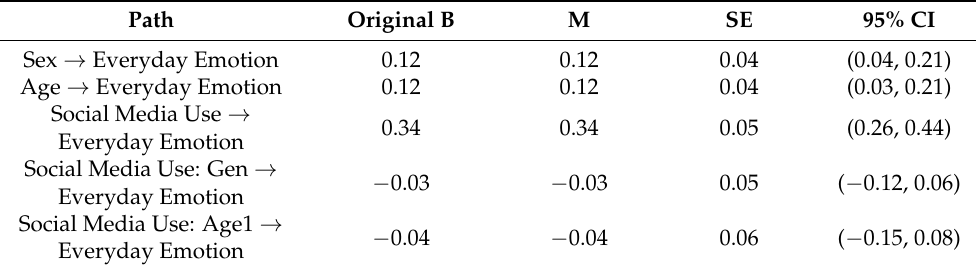
Table 10. Bootstrap results for the inner model regression